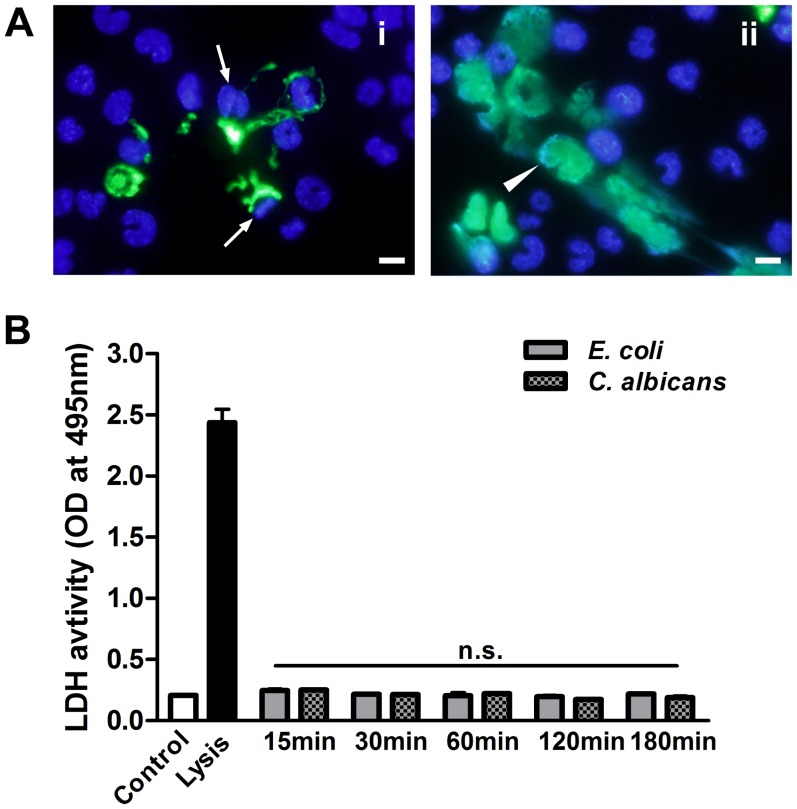
METs-LS-induced cell death is independent of necrosis.
A: The J774A.1 METs-LS induced by C. albicans were stained with SYTOX Green and Hoechst 33342, revealing that the METs-LS are released from either viable (i) or dead (ii) macrophage cells after 120 min incubation. The arrows indicate viable METs-LS formation cells with unchanged nuclei shape, the arrowheads indicate dead MET-LS formation cells with enlarged nuclei. Scale Bars: 10 µm. These experiments were repeated independently 3 times with similar results. C: J774A.1 macrophages were infected with E. coli or C. albicans for 15, 30, 60, 120 and 180 min, respectively. The LDH level in the supernatant of each group was quantified. The data are presented as the means ± SD of three independent experiments.